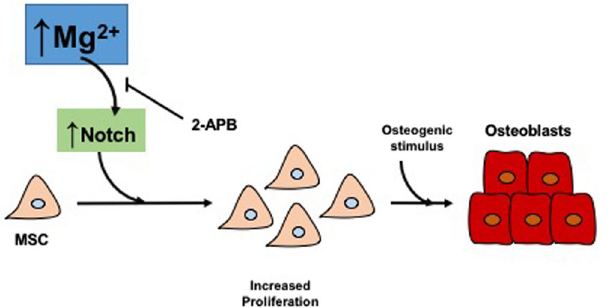
Figure 7. Summary figure. Magnesium supplementation enhances proliferation of MSC. Mechanistically, magnesium ions enter into MSC through TRPM7 channel, increasing Notch Intracellular Domain (NICD) nuclear translocation. Proliferation of MSC contributes to a subsequent osteogenesis. Inhibition of TRPM7 channels by 2-APB decreases the osteogenic potential of